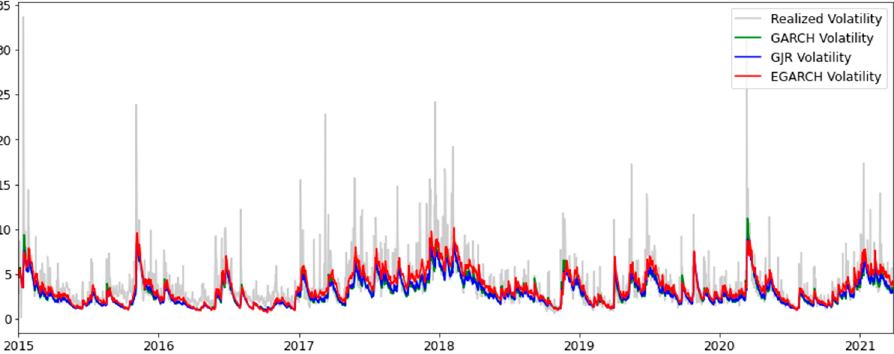
Figure 6. Bitcoin’s realized volatility and GARCH-type models’ estimated volatility from 1 January 2015 to 31 March 2021.